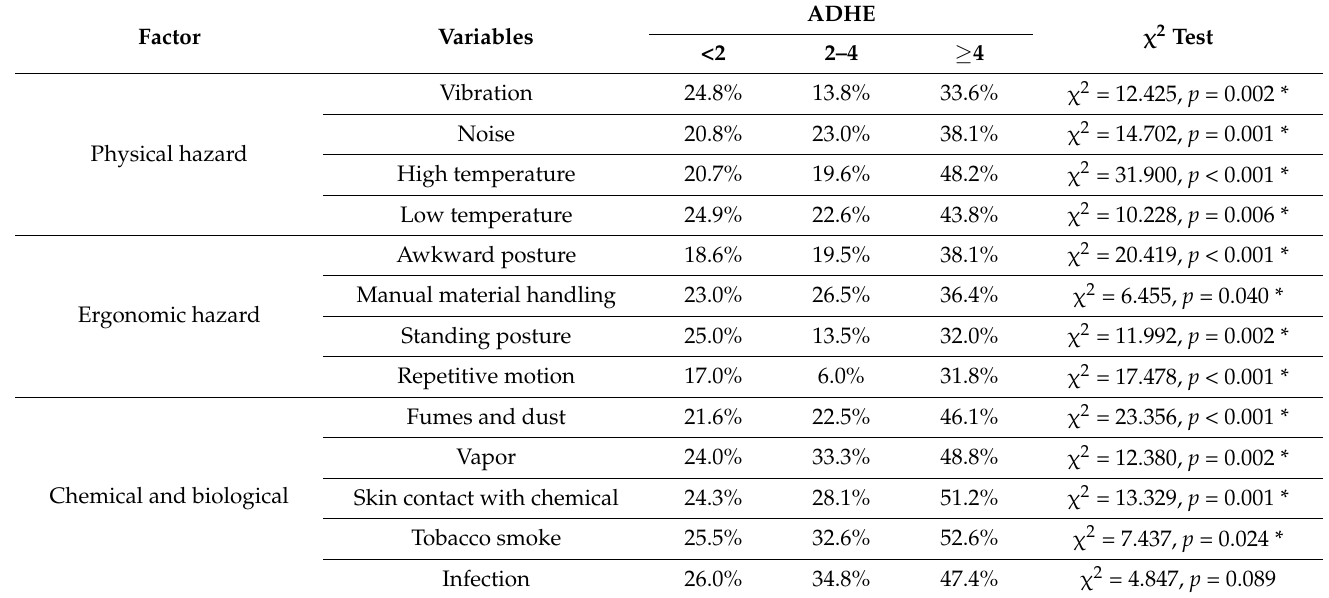
Table 10. Distribution of subjective pain complaints in any one area by the degree of hazard